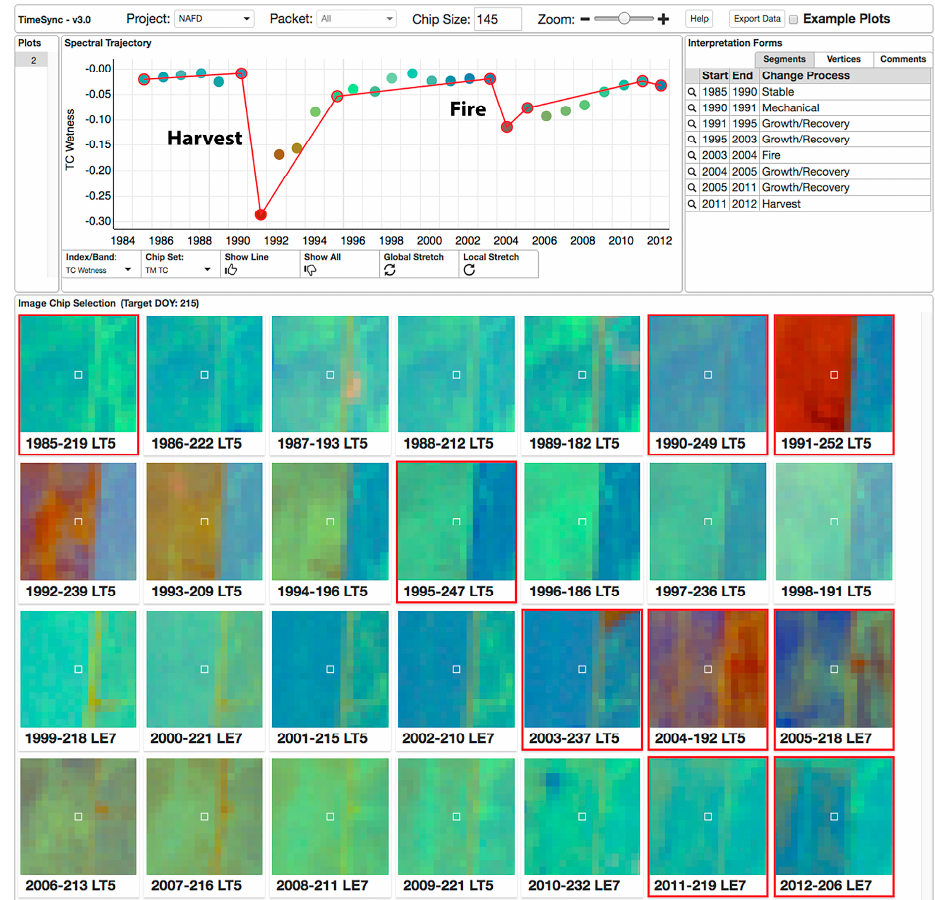
Figure 2. TimeSync interpretation of the pine forest pixel from Figure 1, covering the same time span.